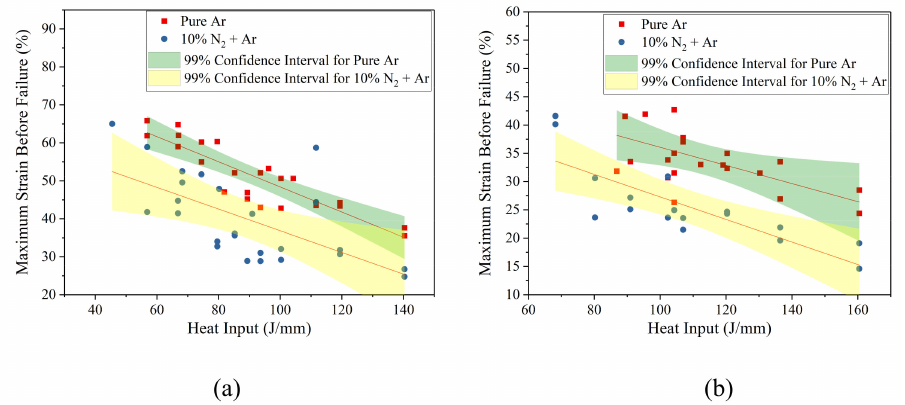
Figure 16. Effect of the addition of nitrogen through the shielding gas on the elongation before failure ( ε ) of welds made homogenously on ( a ) 0.7 mm thick sheets; ( b ) 0.9 mm thick sheets.